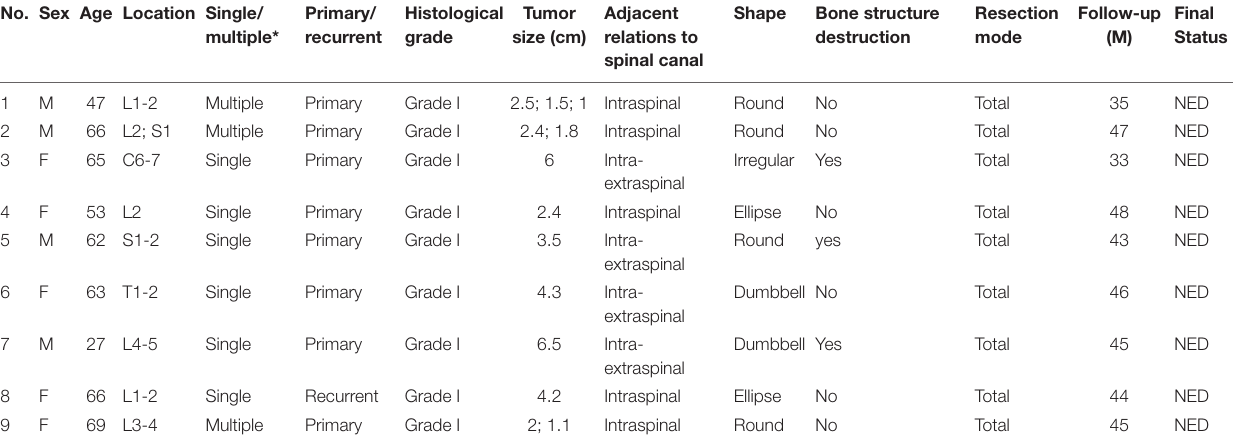
TABLE 1 | Clinical characteristics of nine patients with spinal schwannoma. No. Sex Age Location Single/